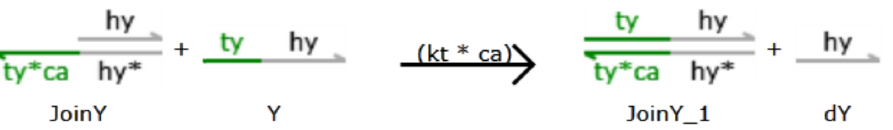
Figure 8. An example of a set of DSD reactions in which their dynamics are equivalent to a degra- k t × c a , −−−→ ∅ dation reaction Y , generated in Visual DSD utilising the Join - Fork templates following [9]. The toehold <ty ∗ ca> has a degree of complementarity of 0 < ca, kt < 1 to the toehold <ty>, effectively slowing down the binding rate from kt to kt ×